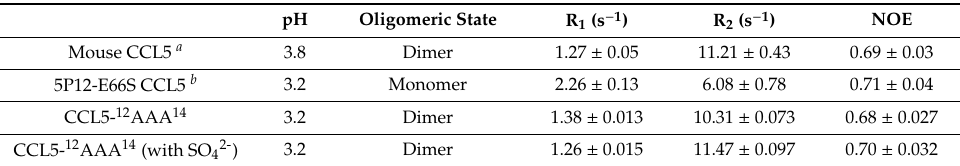
Table 2. NMR dynamic parameters of